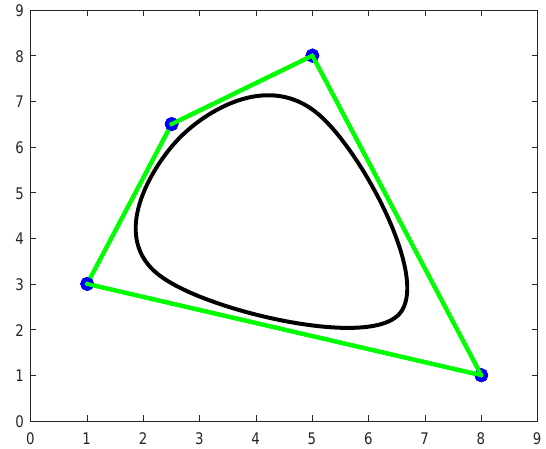
Figure 11. Closed curve using CTBS basis functions.